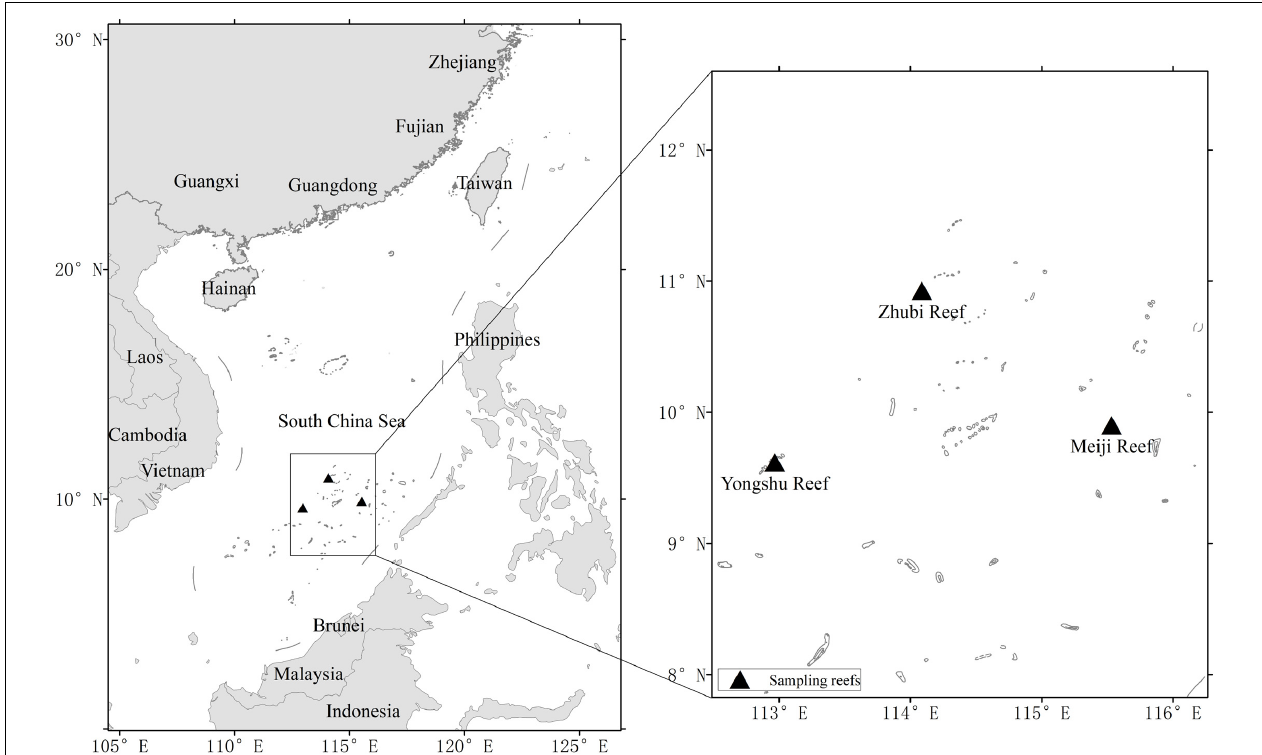
FIGURE 1 | Sampling reefs in Nansha Islands, South China